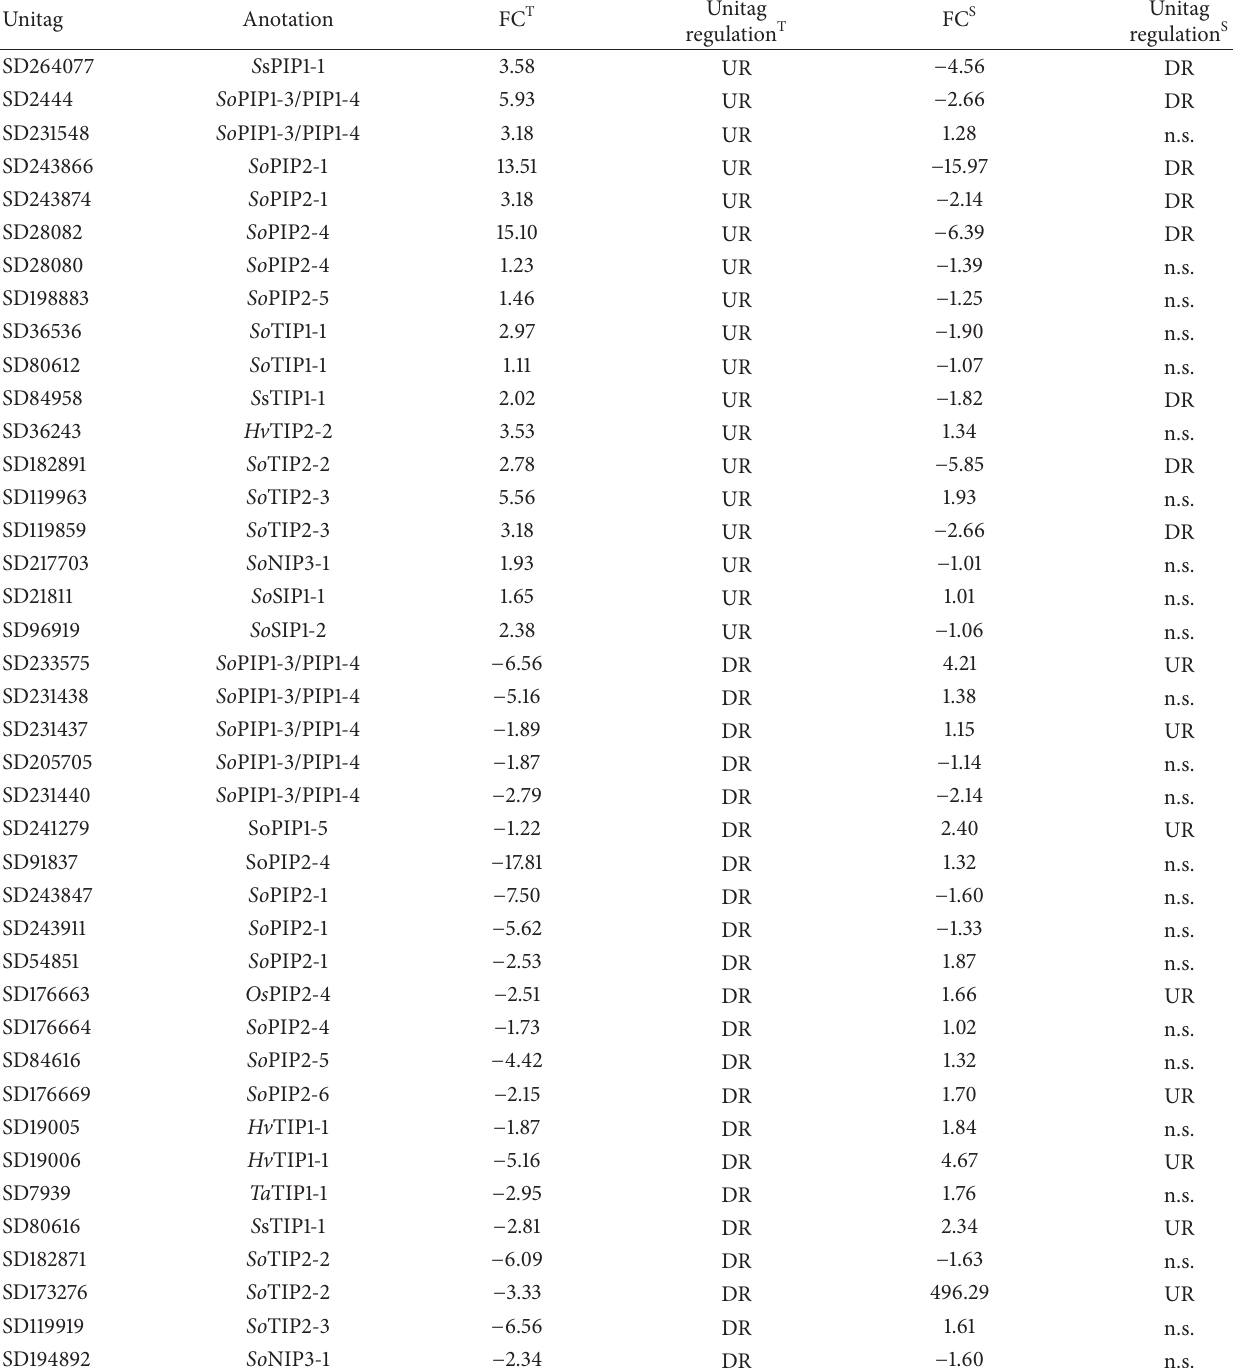
Table 4: Aquaporin unitags with distinct expression rates in root HT-SuperSAGElibraries from contrasts of tolerant T (SD24T versus SDTC) and sensitive S (SD24S versus SDSC) sugarcane genotypes and after continuous dehydration